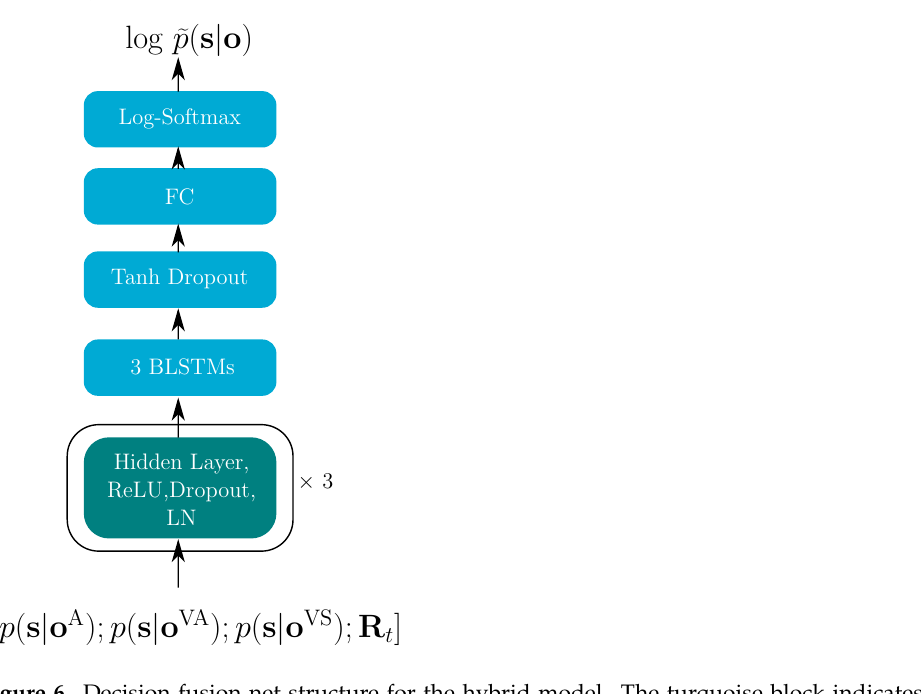
Figure 6. Decision fusion net structure for the hybrid model. The turquoise block indicates the successively repeated